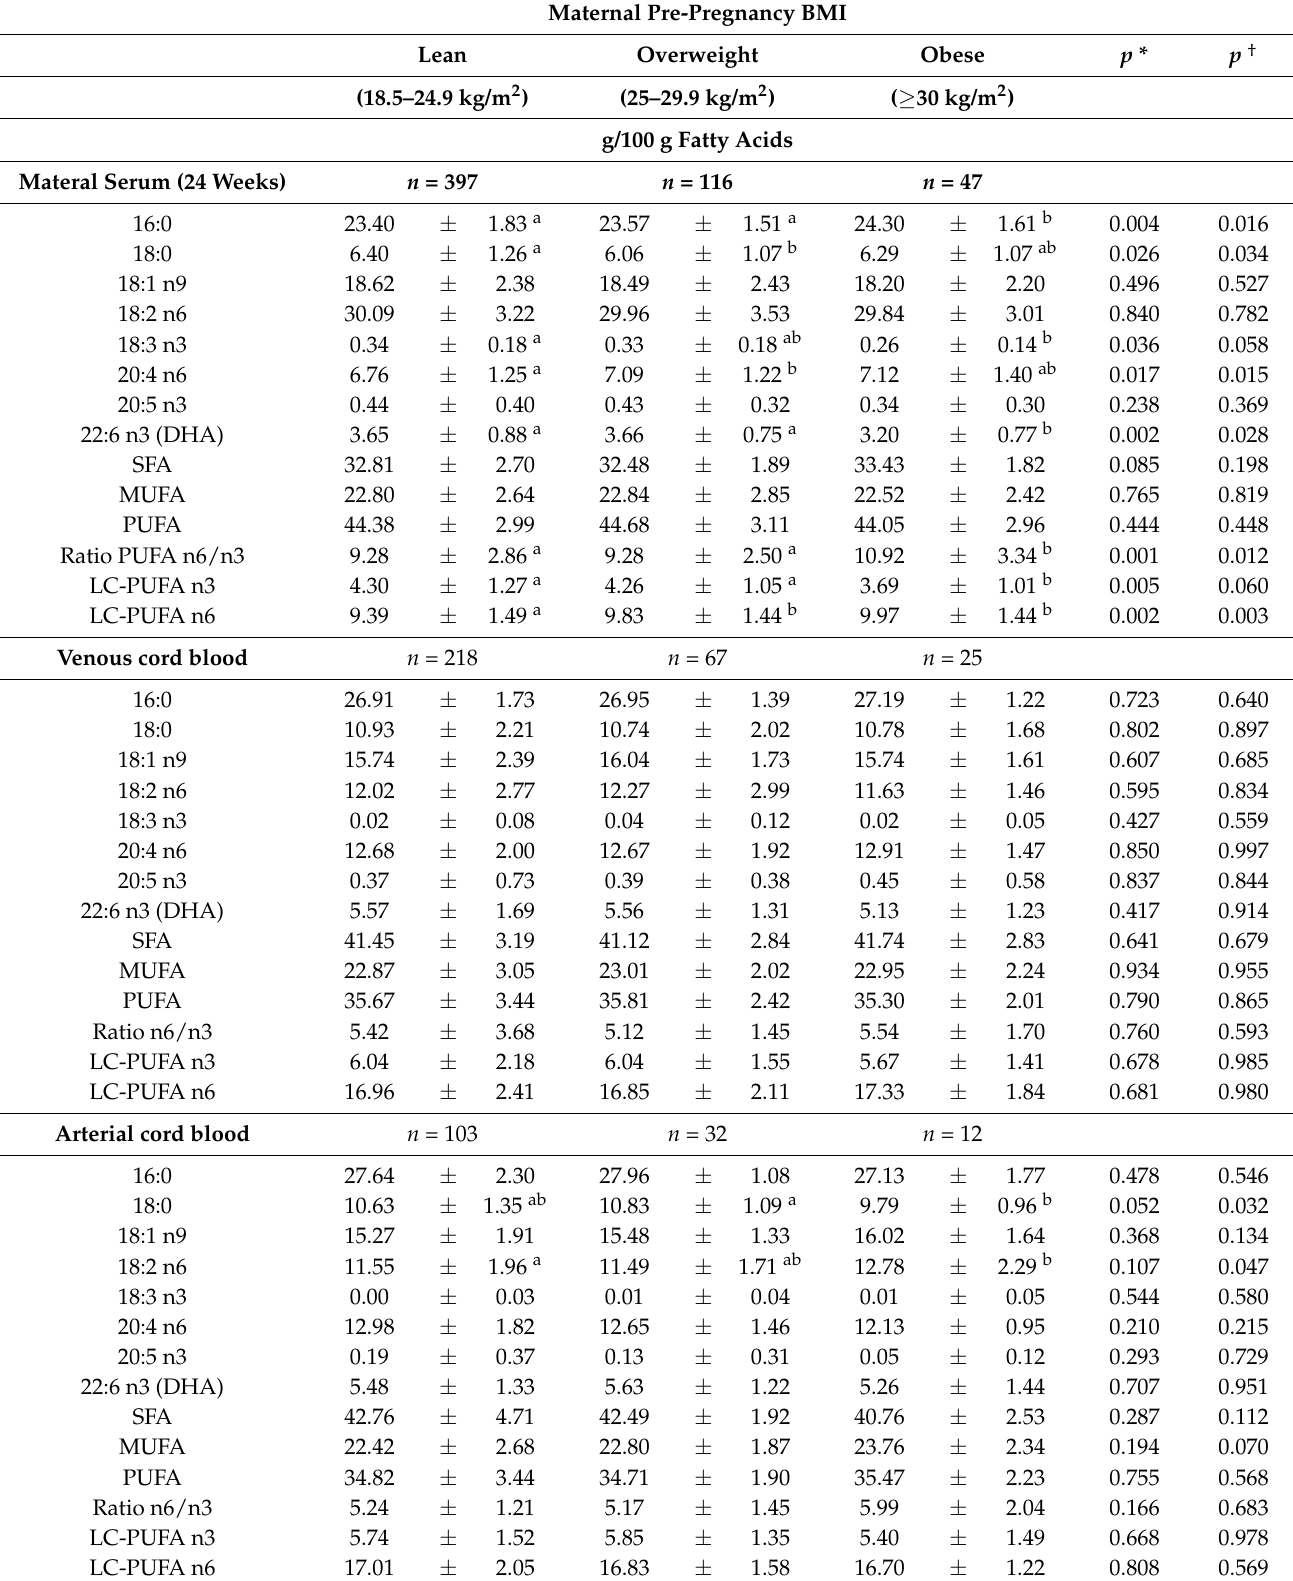
Table 2. Maternal and newborn fatty acid profile according to pre-pregnancy body mass index (BMI). The NELA study (2015–2018).